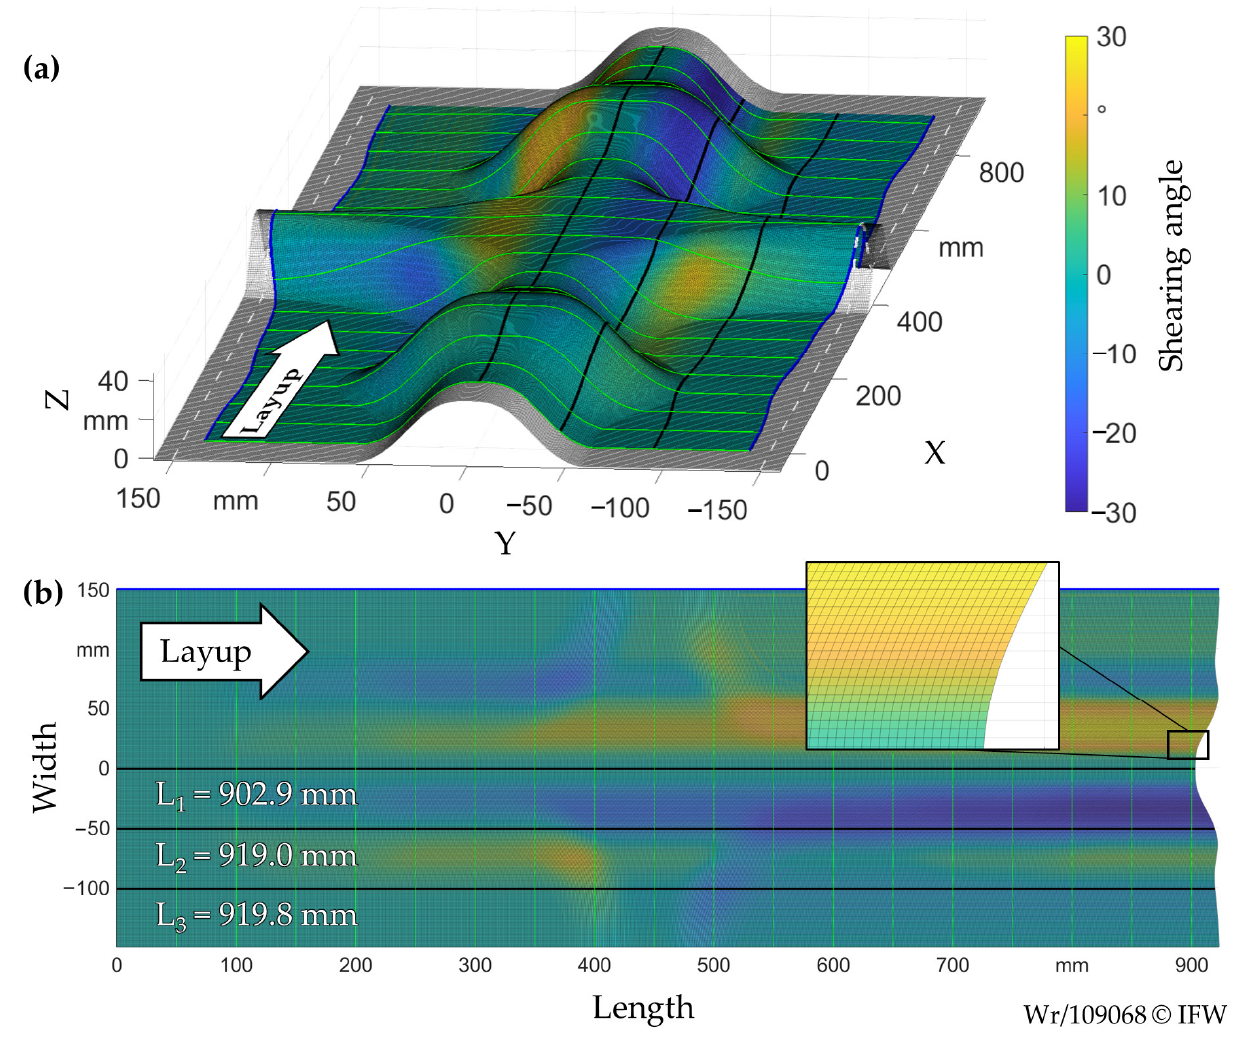
Figure 3. ( a ) Draping simulation on a double-curved stiffener with an intersection; ( b ) prediction of shearing pattern in the undeformed UD-NCF before layup.